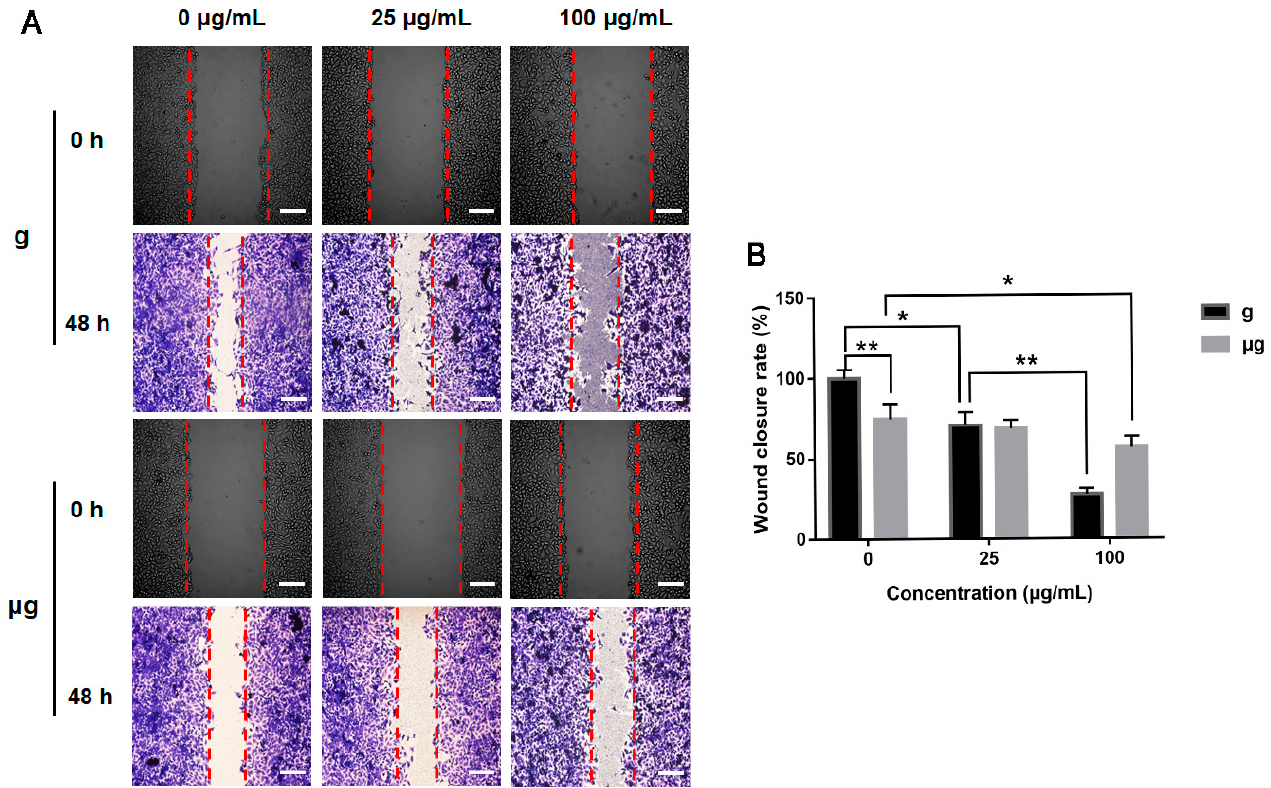
Figure 4. Effect of TiO 2 NPs exposure on A549 cell migration under normal gravity and simulated microgravity. ( A ) A549 cells were treated with TiO 2 NPs (0, 25 and 100 µ g/mL) for 48 h under normal gravity (g group) and simulated microgravity ( µ g group), respectively. Images were taken at 0 and 48 h after scratching. The red dotted lines show the boundaries of the migratory A549 cells (scale bar: 100 µ m). ( B ) Quantitative analysis of relative cell wound closure rates. The histograms represent the mean ± SD of at least three independent experiments. * p < 0.05, ** p < 0.01.